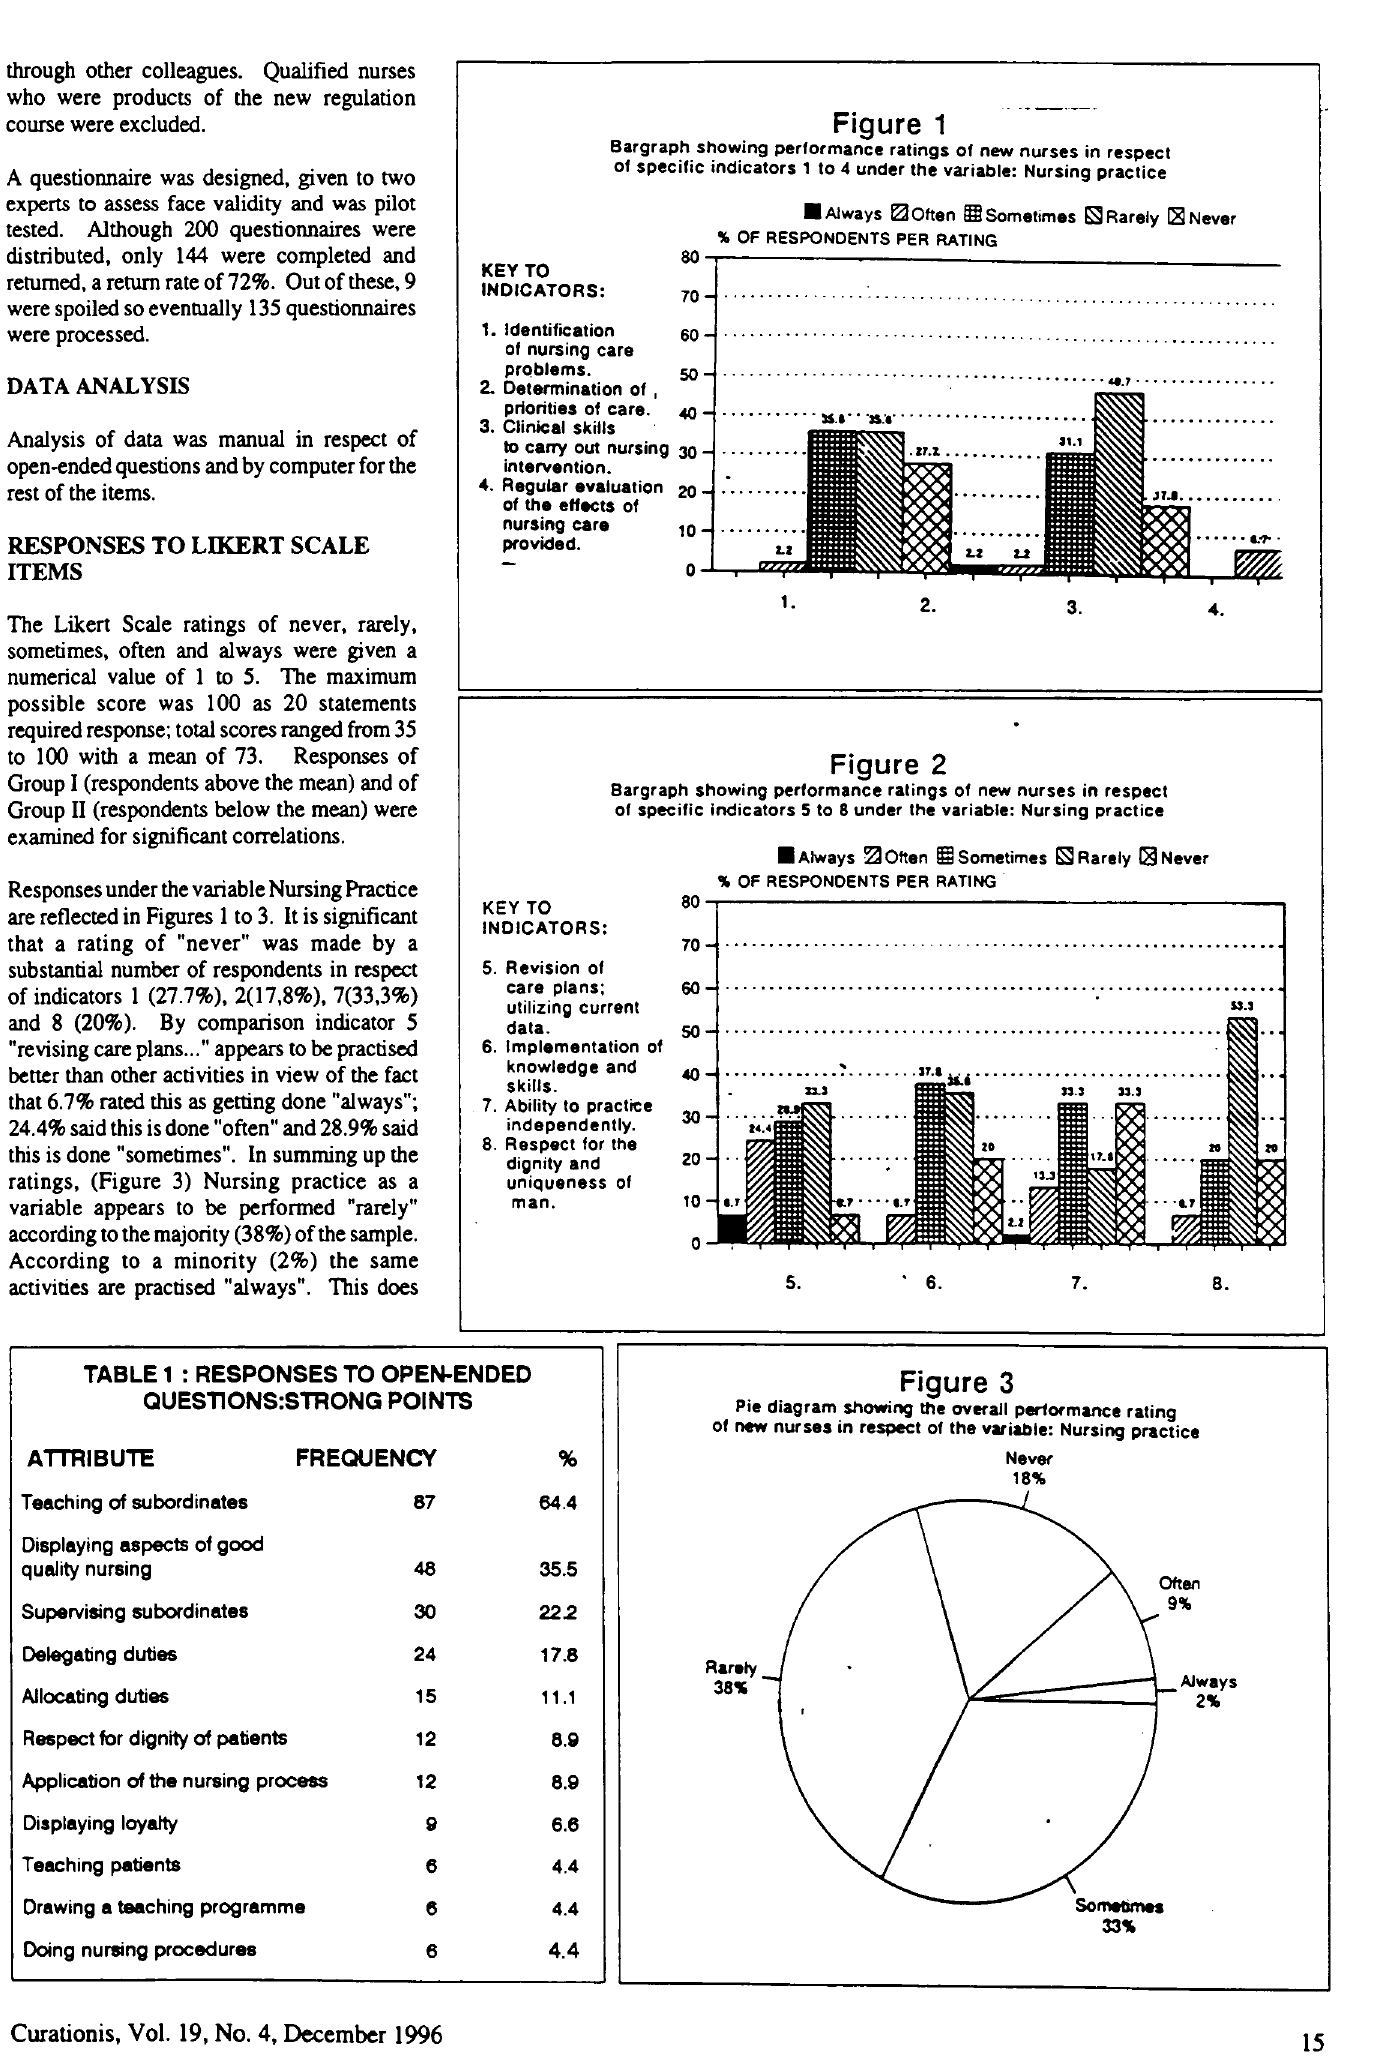
Pie diagram showing the overall performance rating of new nurses in respect of the variable: Nursing